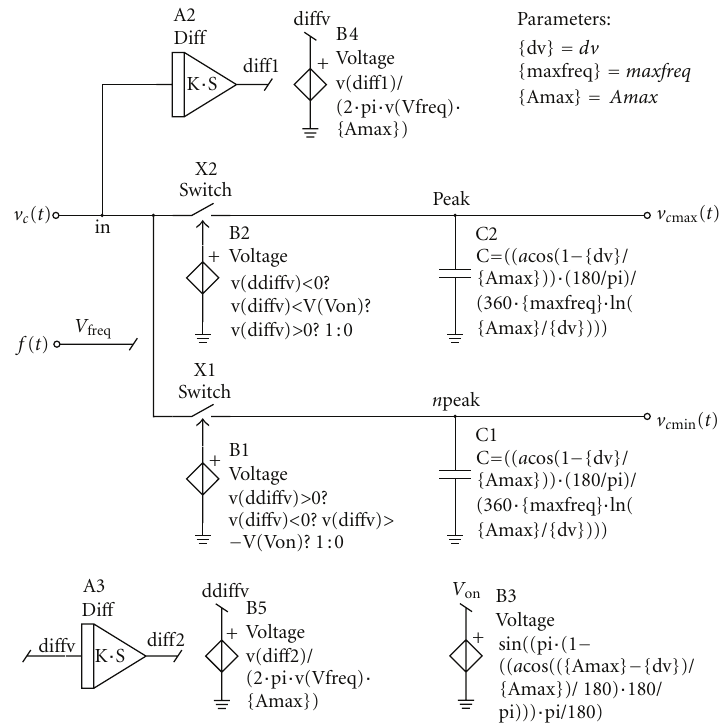
Figure 3: Peak detector